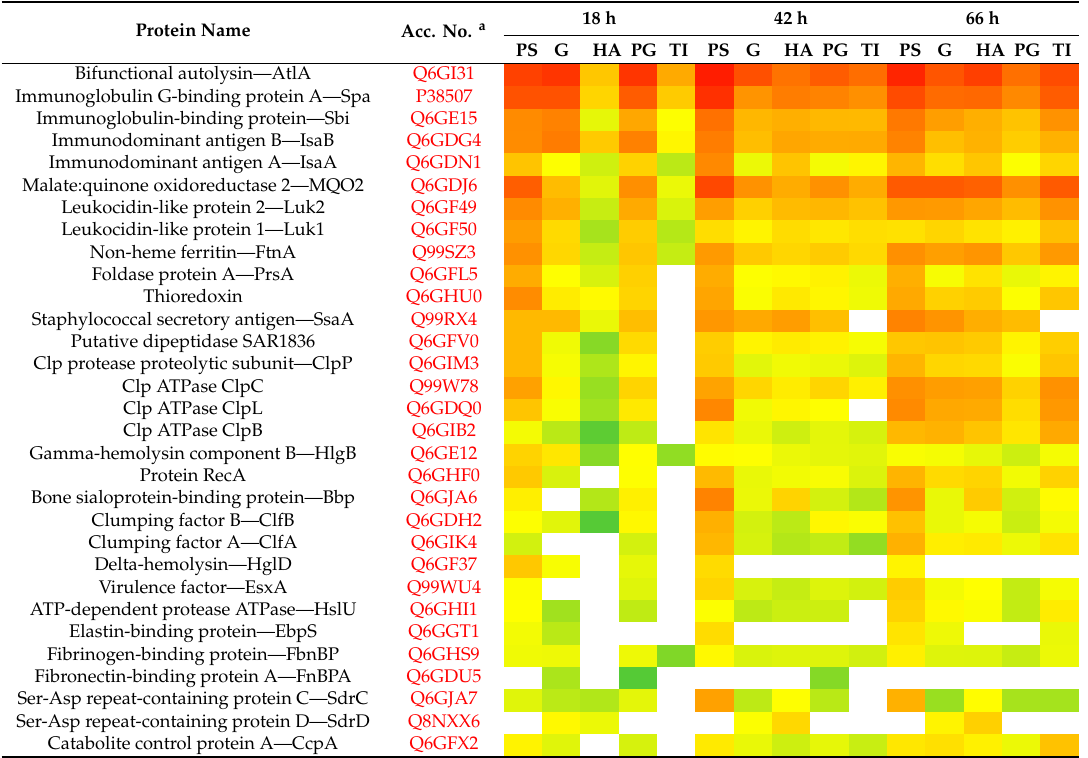
Table 2. A heatmap comparing the intensity values (log 10 ) of selected protein